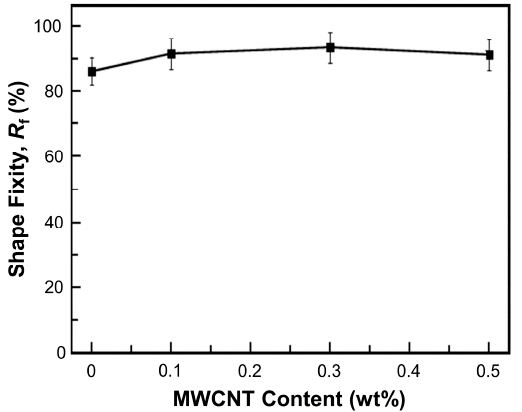
Figure 10. Shape fixity of MWCNT reinforced V-fa/ECO composites at various MWCNT contents.